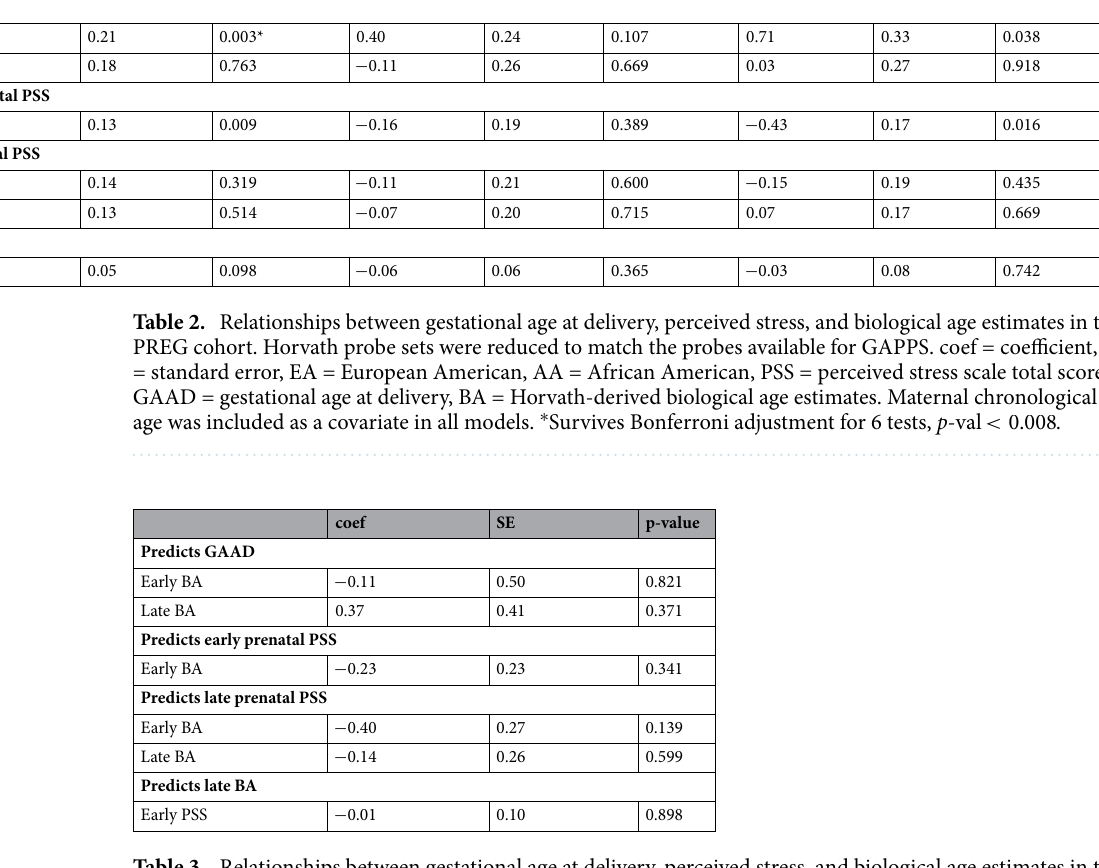
Table 3. Relationships between gestational age at delivery, perceived stress, and biological age estimates in the GAPPS replication cohort. Horvath probe sets were reduced to match the probes available for PREG. coef = coefficient, SE = standard error, PSS = perceived stress scale total score, GAAD = gestational age at delivery, BA = Horvath-derived biological age estimates. Maternal chronological age was included as a covariate in all ∗ models. Survives Bonferroni adjustment p -val < 0.008